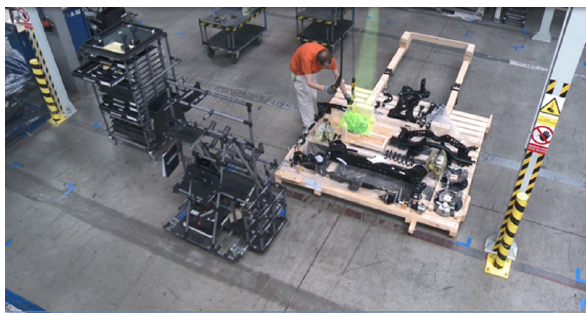
Figure 7: The lighting of parts after allocation in the right position.